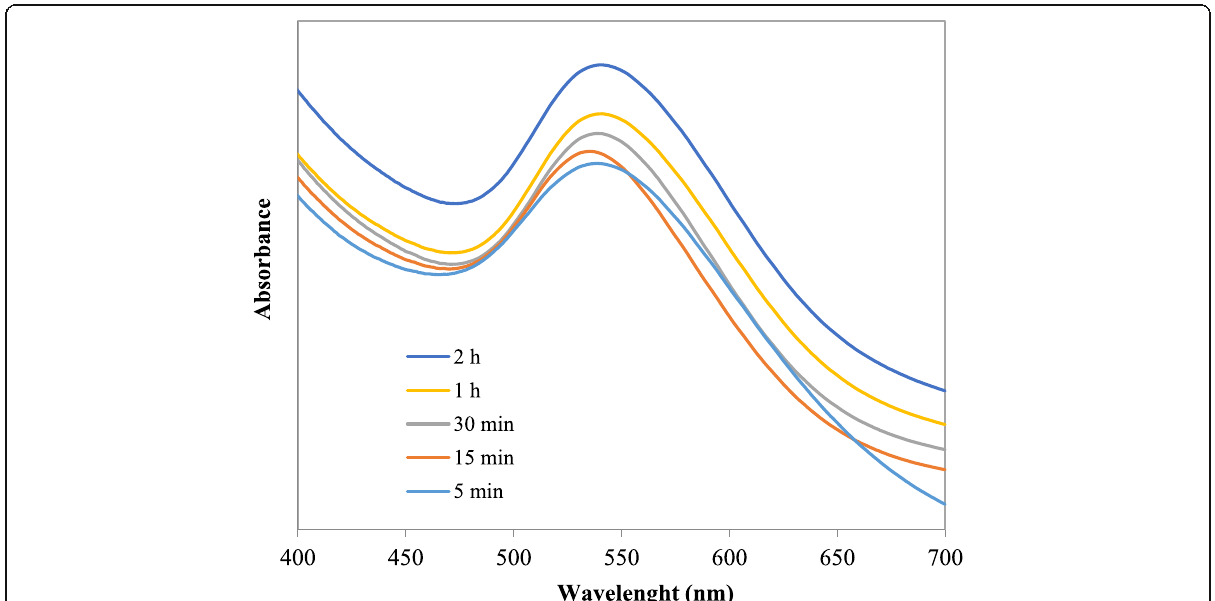
Fig. 3 UV-Vis spectra of AuNPs during reaction 25 mL of HAuCl 4 .3H 2 O(1 mM) with 4 mL of Jujube extract after 5, 15, 30 min, 1 and 2